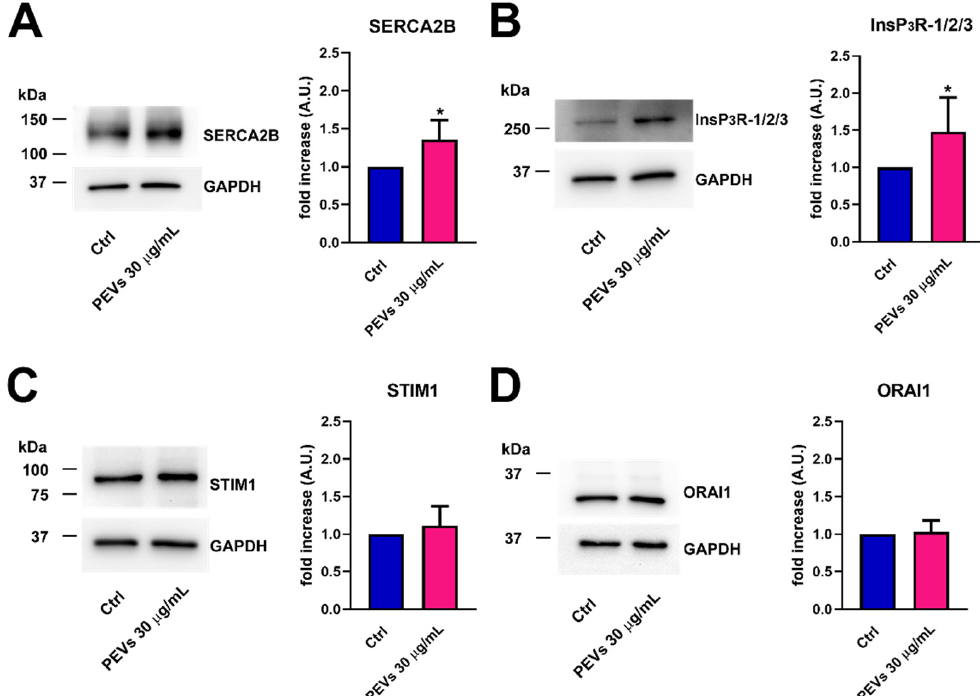
Figure 4. The treatment of MDA-MB-231 cells with PEVs increases the protein expression of SERCA2B and InsP 3 Rs. Representative immunoblots of SERCA2B and InsP 3 Rs are reported in ( A , B ), respectively, where GAPDH is for equal loading control (left panel). Quantification of the results performed by densitometric scanning is reported in the right panels as fold increase (A.U.) of protein expression over basal (control, Ctrl). Results are the mean ± SD of three different experiments. * indicates p < 0.05. Conversely, long term exposure of MDA-MB-231 cells to PEVs do not cause differences in the expression level of STIM1 and Orai1. The left panels of ( C , D ) show the representative immunoblots of STIM1 and Orai1, respectively, while the right panels show band quantifications reported as fold increase (A.U.) of protein expression over basal (Ctrl). Results are the mean ± SD of three different experiments.